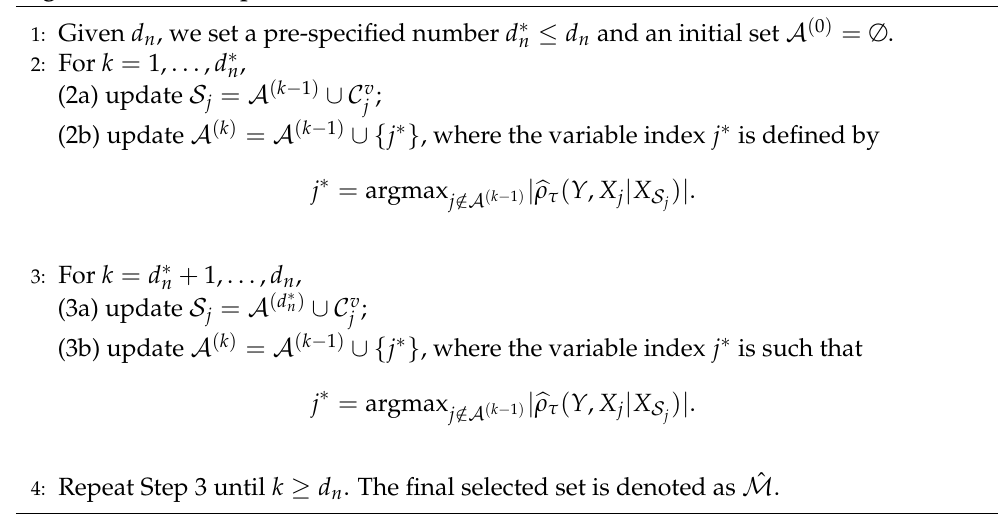
Algorithm 1 The implementation of